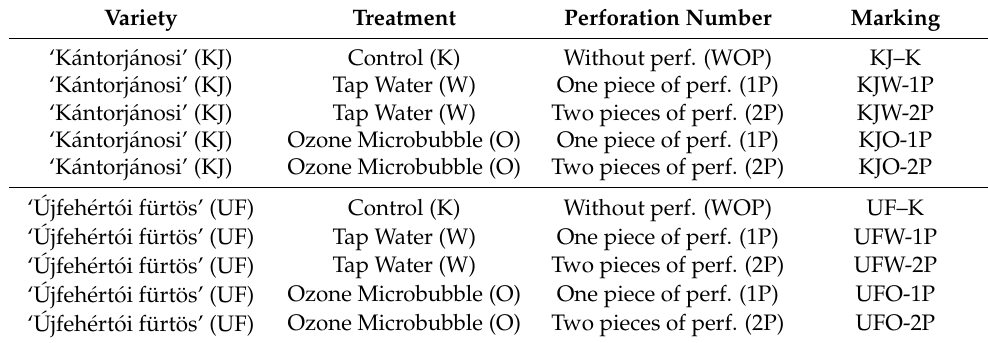
Table 1. Sample treatment and packaging groups in Experiment